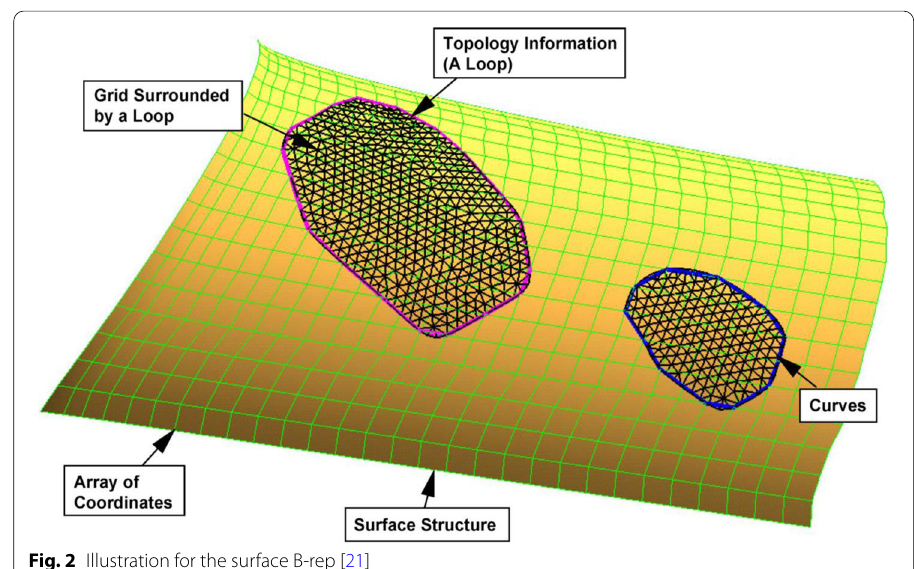
Fig. 2 Illustration for the surface B-rep